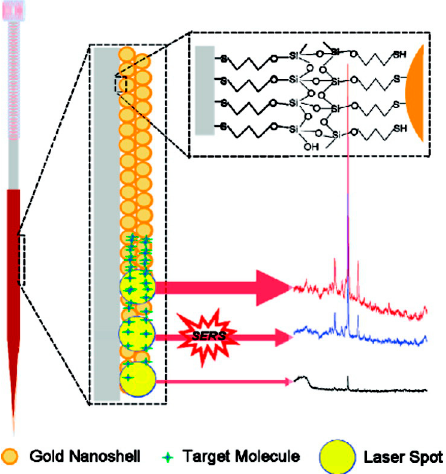
Figure 3. Illustration of the structure of a SERS-active needle and the SERS detection of a depth profile based on the SERS-active needle. Reprinted with permission from [69].